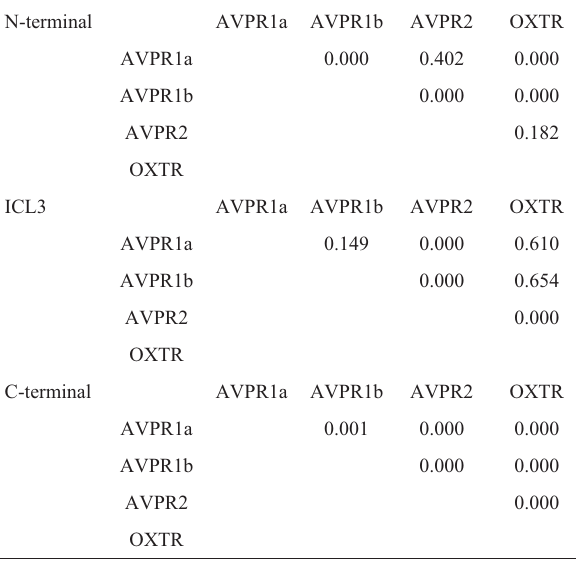
Table 3 - Mann-Whitney test results for pairwise comparisons* between N-terminal, ICL3, and C-terminal regions of OXTR, AVPR1a, AVPR1b, and AVPR2 regarding their intrinsic disorder degree